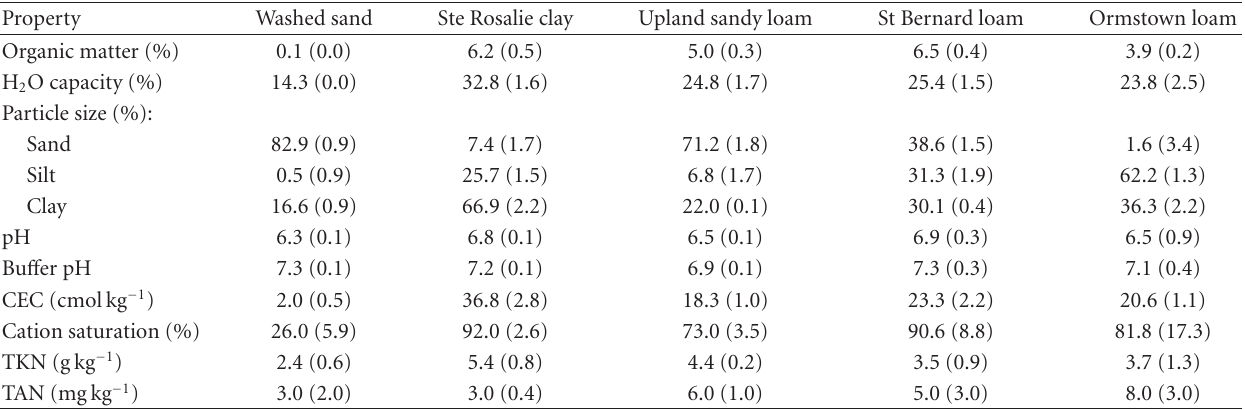
Table 2: Characteristics of the five experimental soils used to measure NH 3 volatilization for the two experimental manures, untreated (open tank) and anaerobically treated (ISPAD).